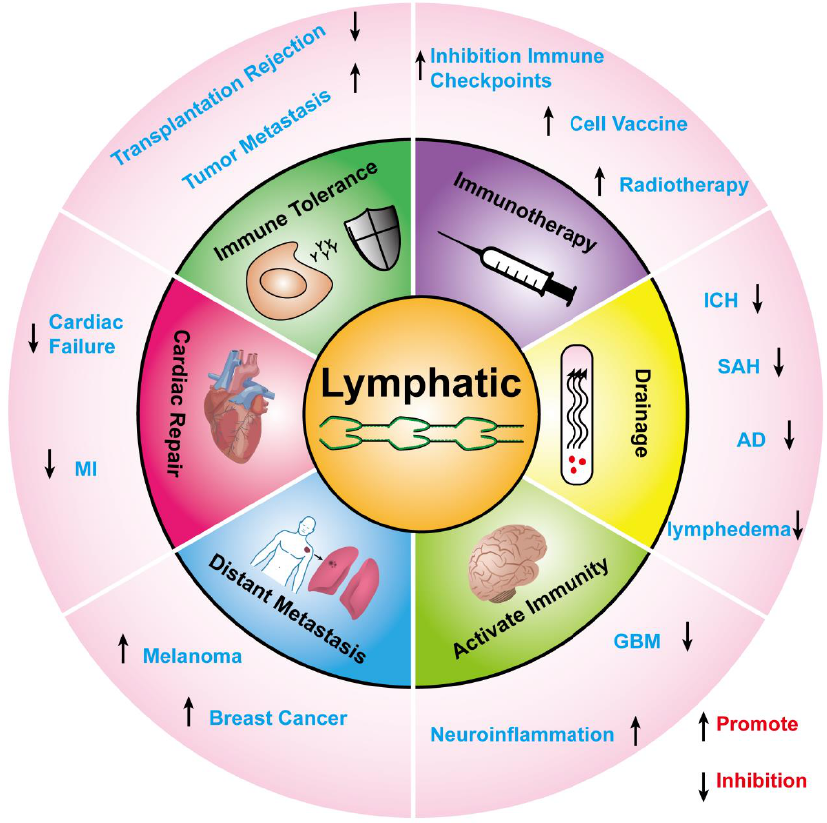
Figure 1. The function of lymphatic